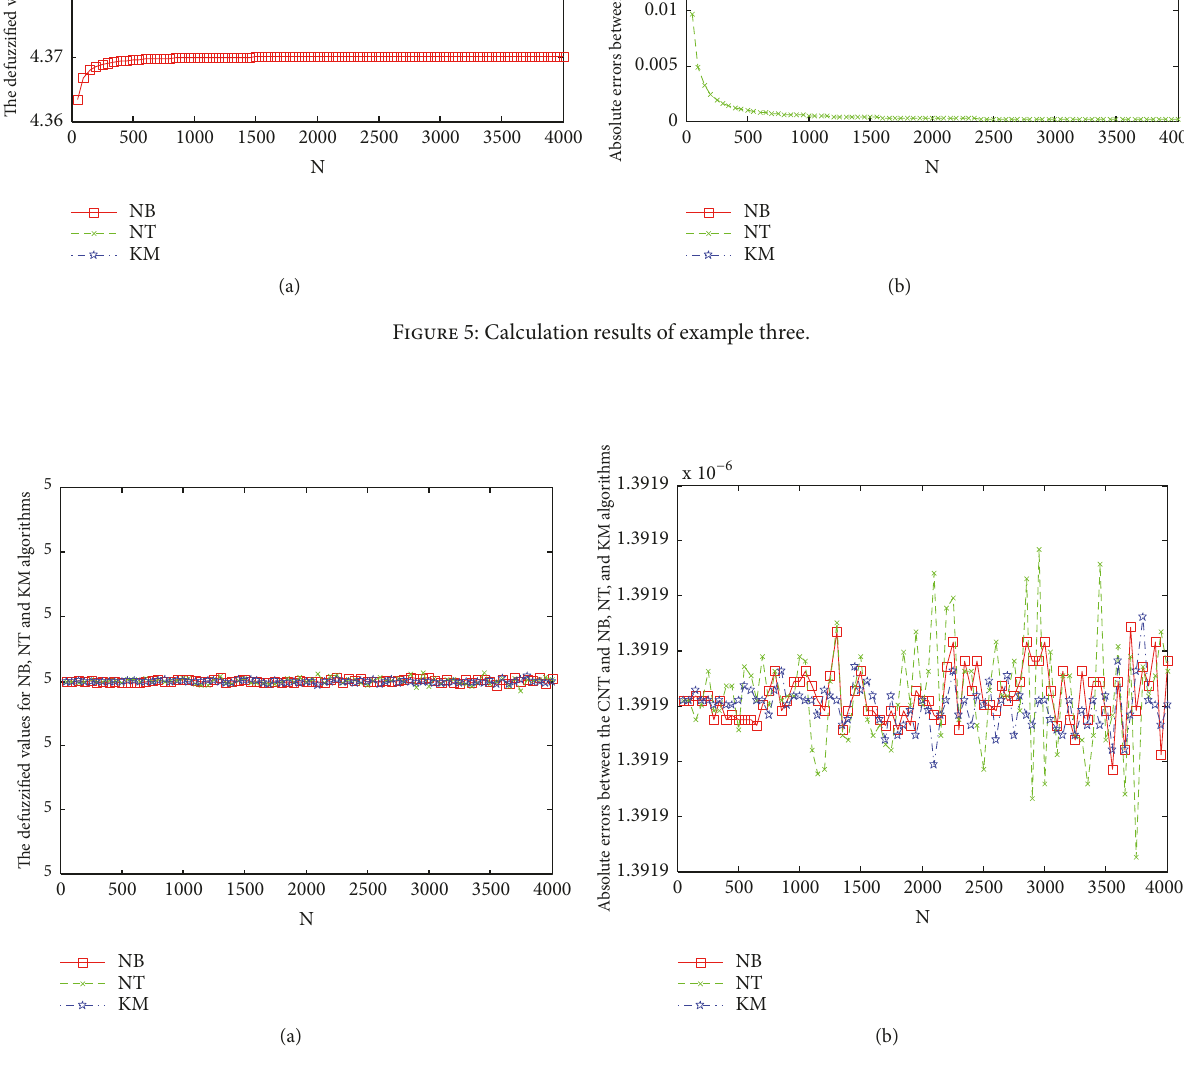
Figure 6: Calculation results of example